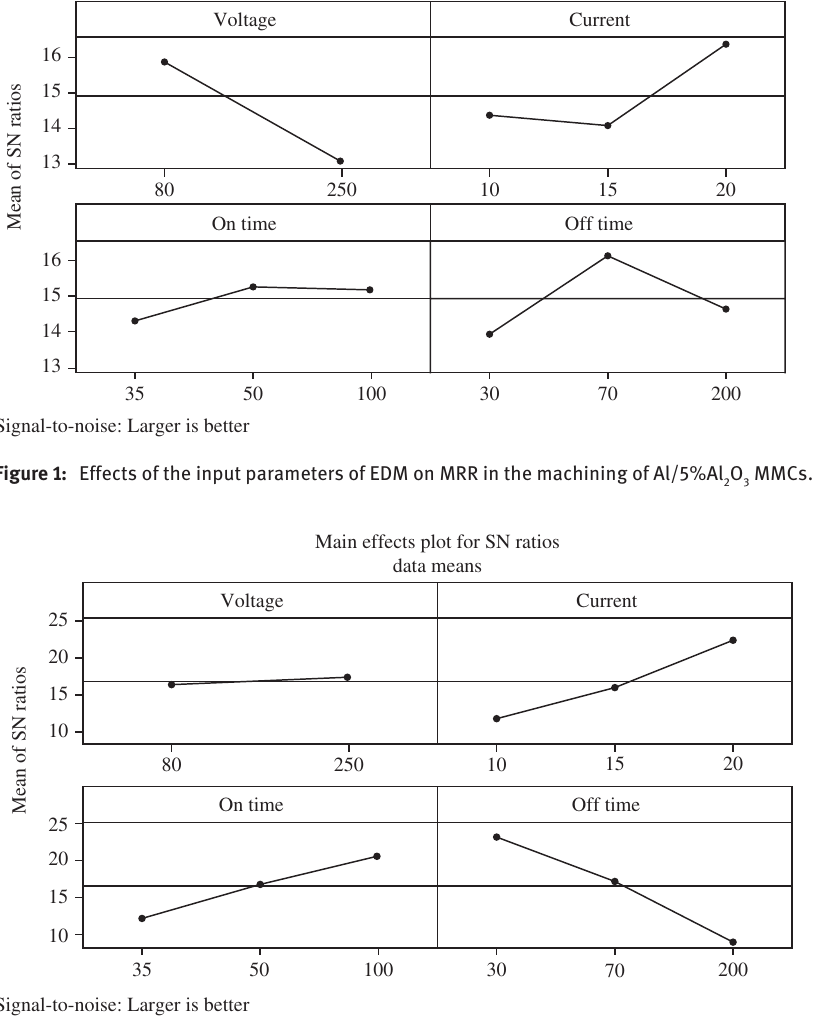
Figure 2: Effects of the input parameters of EDM on MRR in the machining of 2024 alloy. Table 7: Analysis of variance for MRR in the machining of Al/5%Al Source